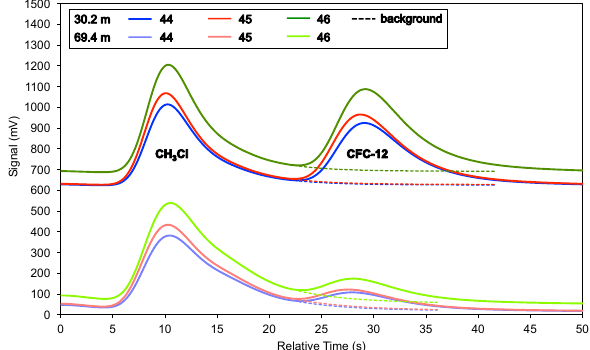
Fig. 1. Plot of δ 13 C (CFC-12, vs. VPDB) against peak area shows sample size linearity of isotope ratio measurements of the calibra- tion mixture (34 samples). Horizontal lines indicate mean (solid) and instrument ± 2 σ (dashed).